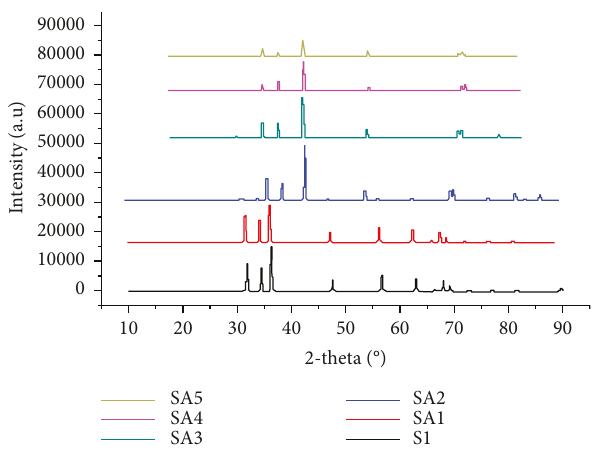
Figure 3: XRD patterns of ZnO